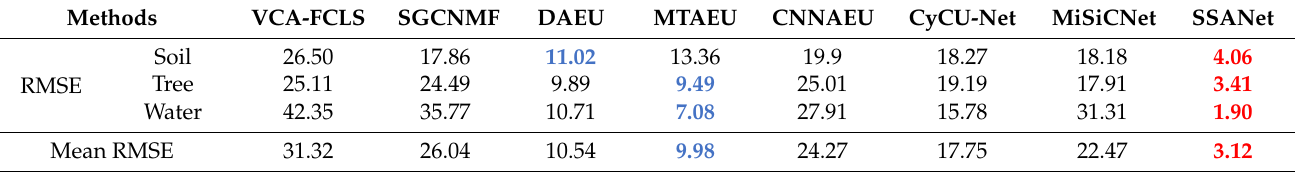
Table 2. RMSE ( × 100) and mean RMSE ( × 100) of abundances acquired by various unmixing approaches on Samson data. Annotation: bold red text indicates the best results and bold blue text indicates the suboptimal